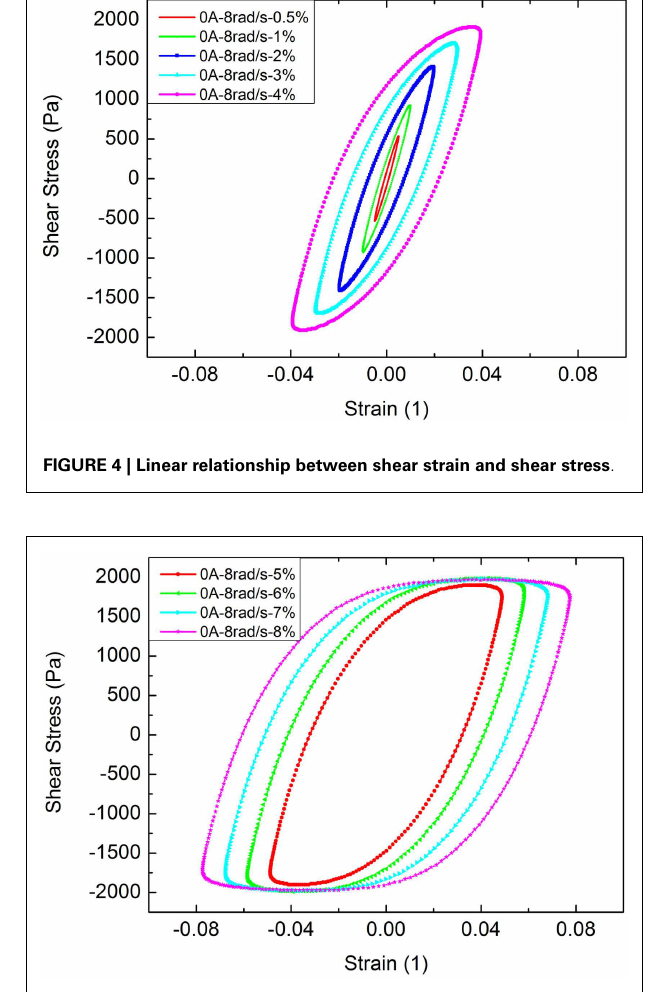
FIGURE 5 | Non-linear relationship between shear strain and shear stress .